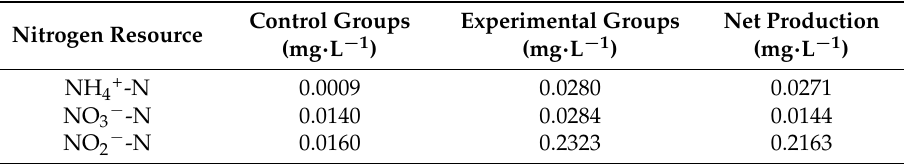
Table 2. The concentration of N 2 O produced during nitrogen removal process.